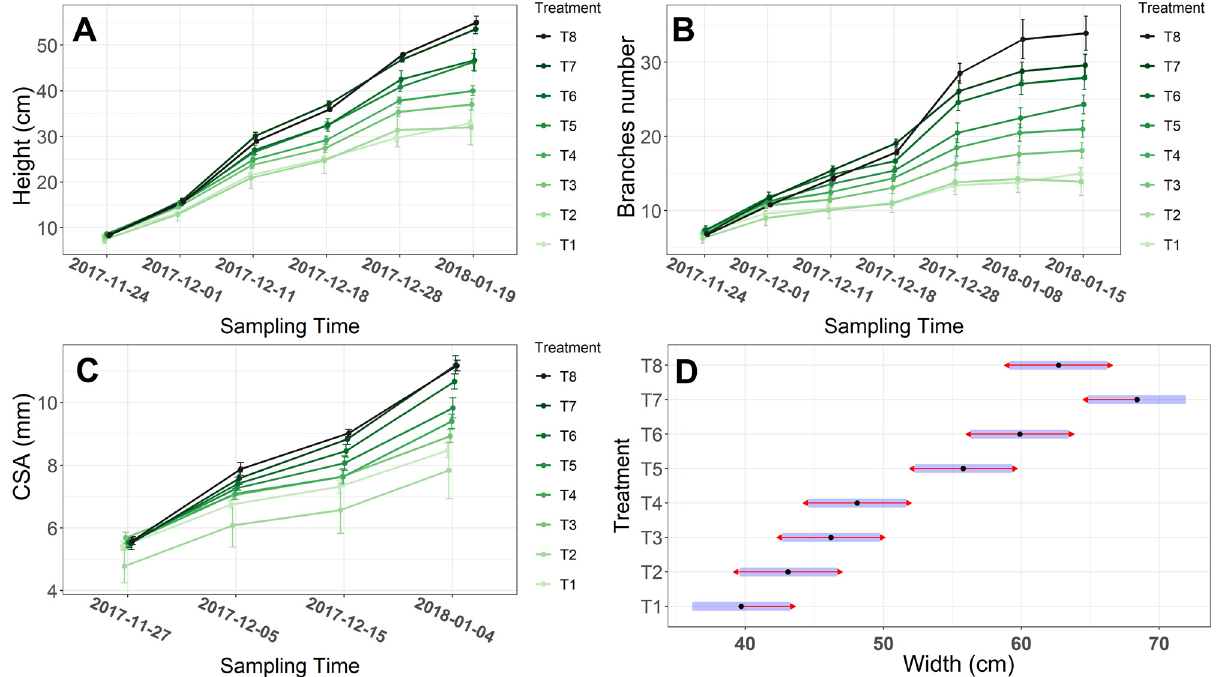
Figure 2. Line graphs of plant growth measurements including mean values of stem height in cm ( A ), number of branches ( B ), stem CSA in mm ( C ) and leaf width at the completion of the trial in cm ( D ) for increasing UWP supplement rates (T1 = 0.3%; T2 = 0.5%; T3 = 0.8%; T4 = 1%; T5 = 2%; T6 = 3%; T7 = 5%), and Hoagland’s solution (T8). x -axis represents sampling event in weeks after planting. Error bars denote standard error ( A – C ). Plant width ( D ) represents a single sampling event. When arrows overlap among treatments, then the treatments are not significantly different.